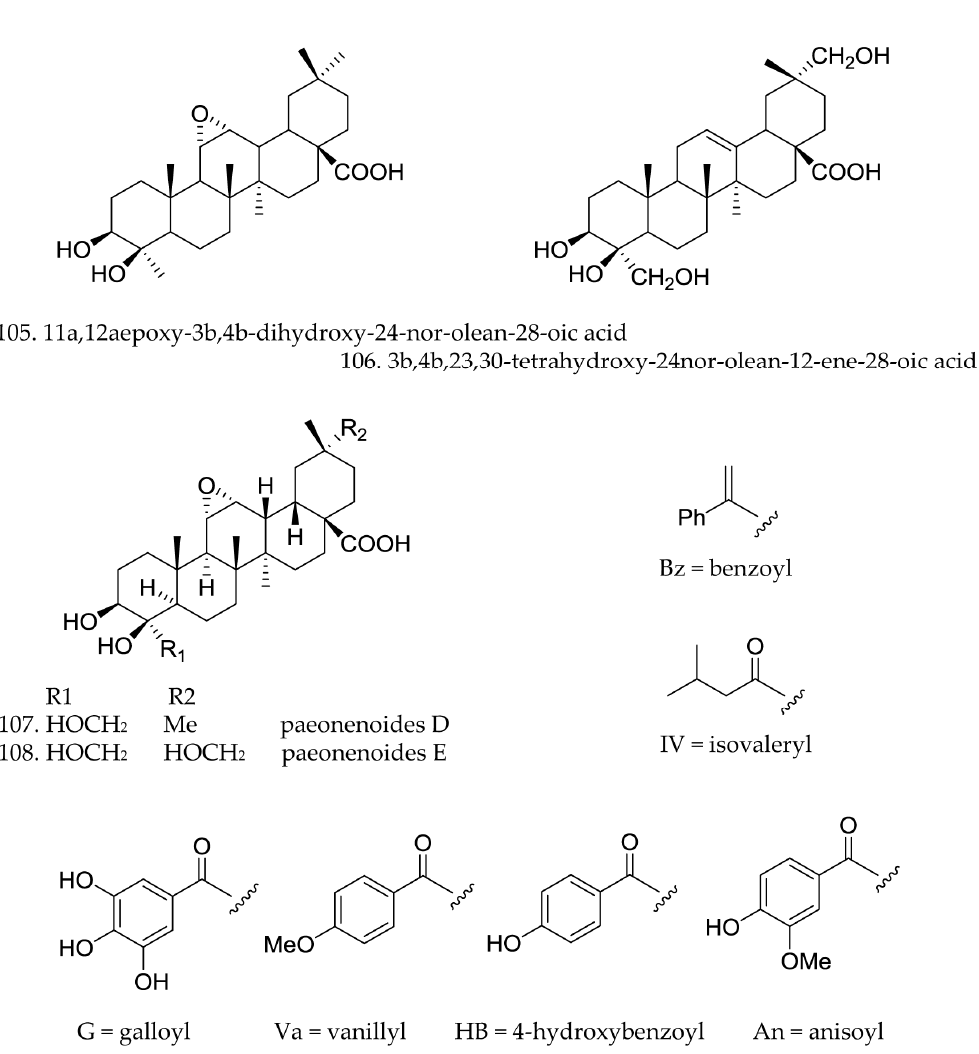
Figure 4. Chemical structures of triterpenes.